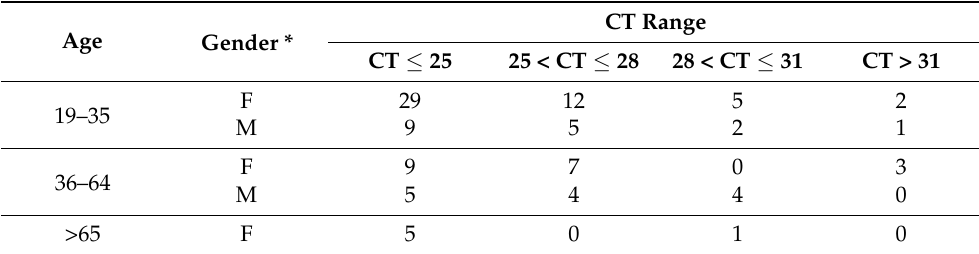
Table 2. Characteristics of SARS-CoV-2 positive patient group by age, gender and CT values obtained in RT-qPCRs.